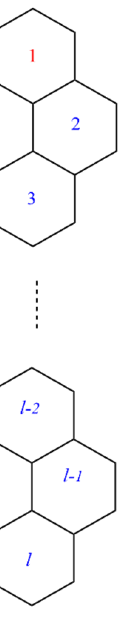
Figure 8 . Graphene structure with 𝑙 > 1, 𝑘 = 1 . Figure 8. Graphene structure with l > 1, k =